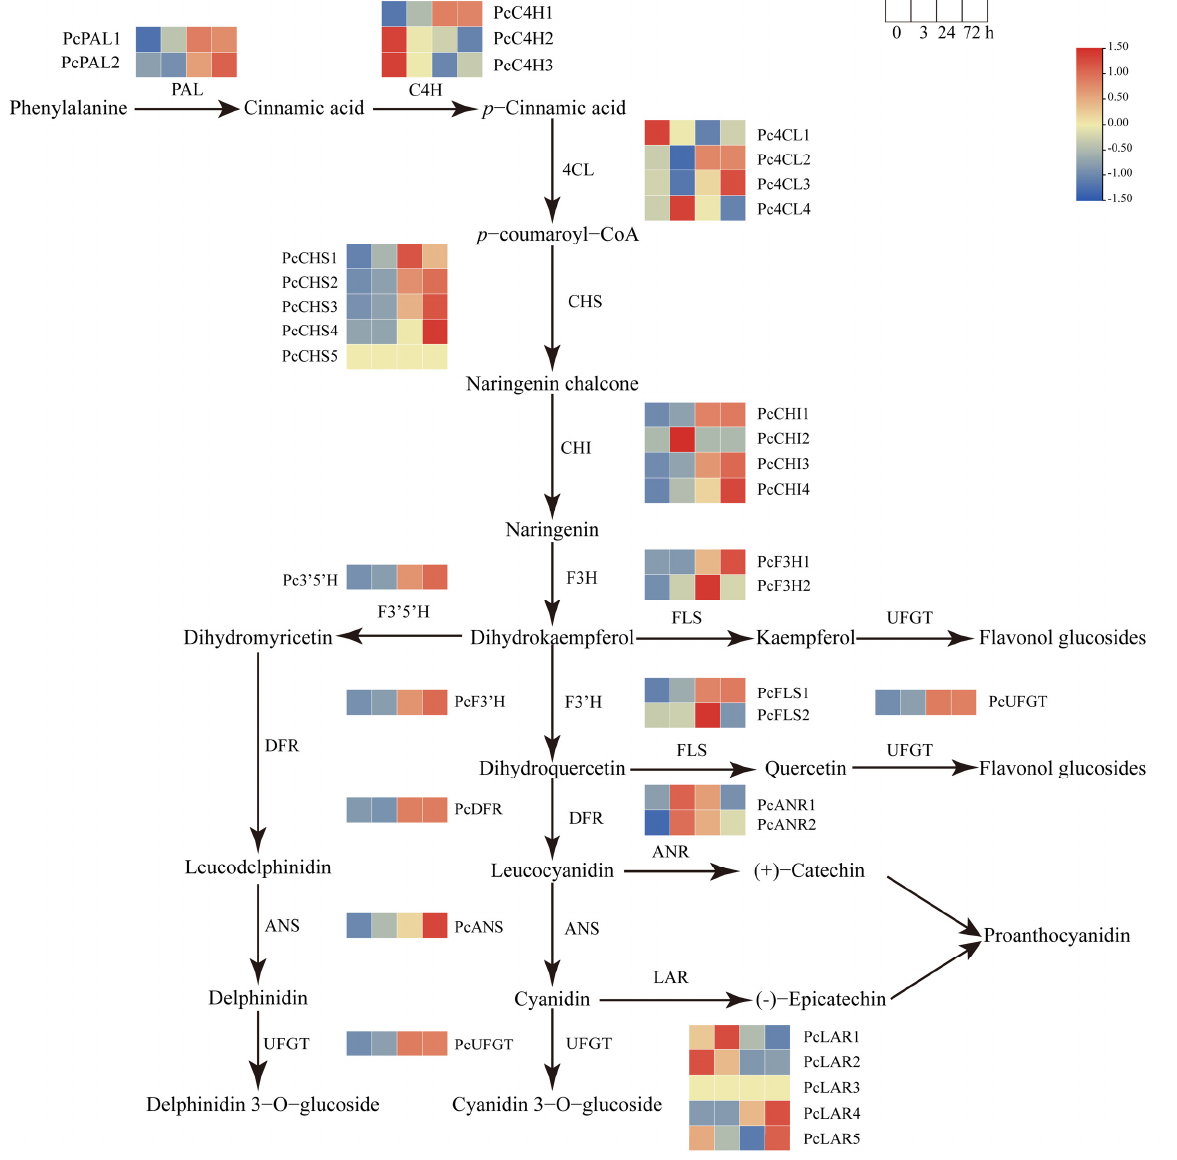
Figure 6. Heatmap of the expression profiles of structural genes involved in anthocyanin biosynthesis pathways under sucrose treatment. The color scale indicates the gene expression levels. Red indicates a high expression level and green indicates a low expression